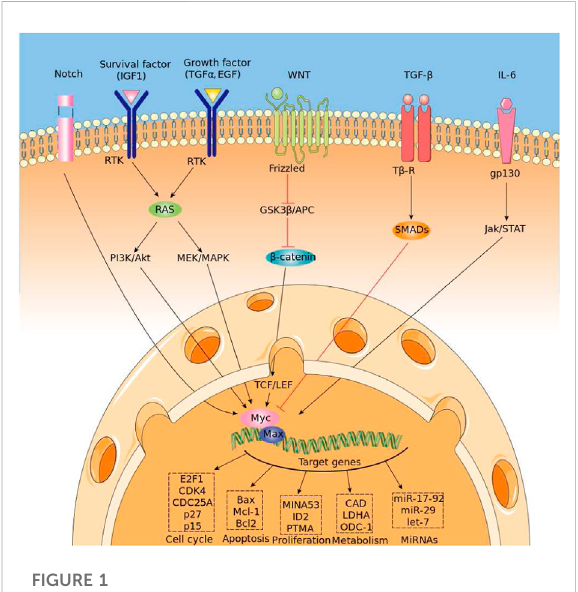
FIGURE 1 Regulation of MYC expression and binding